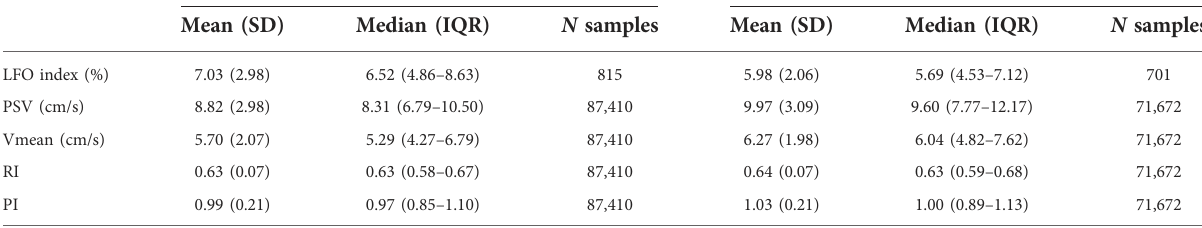
TABLE 1 Cerebral hemodynamics in healthy